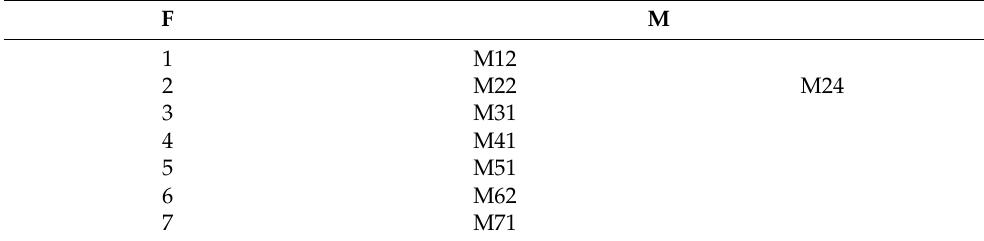
Table 5. Conceptual design refined morphological chart of the transmission device. F M